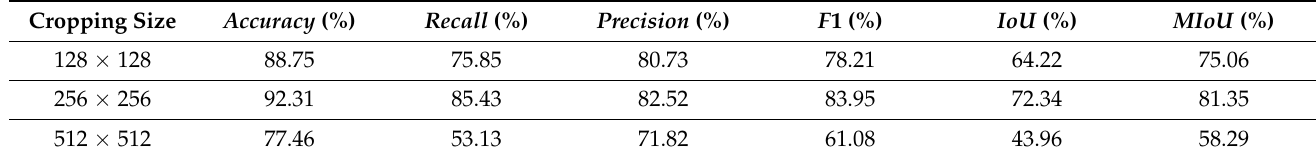
Figure 8. The test results under the 512 × 512 px cropping size. Table 4. Comparisons of accuracy under different cropping